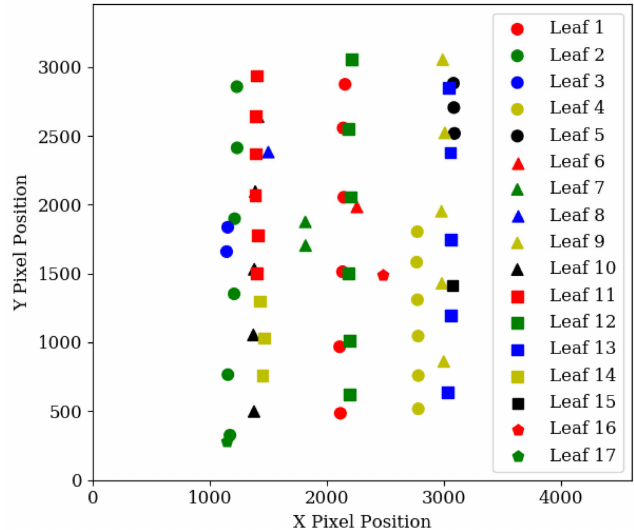
Figure 10. Bounding box data from the artificial plant that have been grouped according to origin leaf, using the unsupervised grouping algorithm. The algorithm successfully grouped all instances of the same